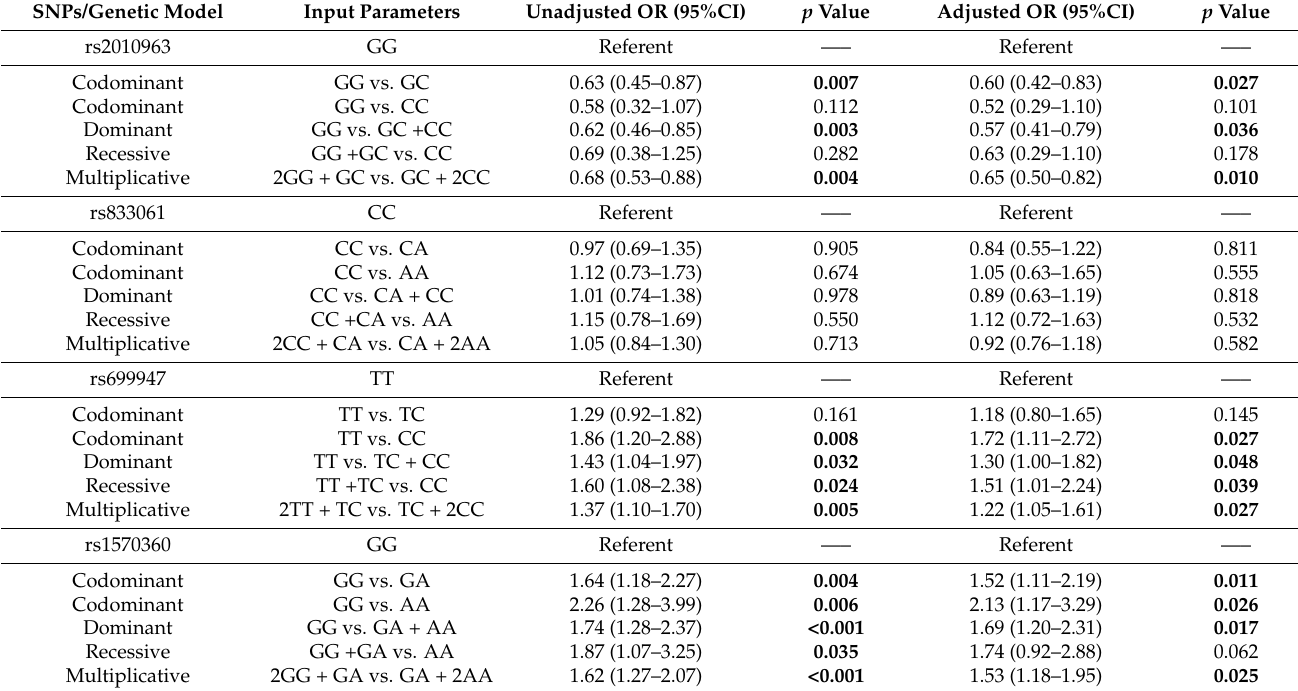
Table 5. Association of VEGFA gene SNPs for the endothelial dysfunction associated osteoporosis.